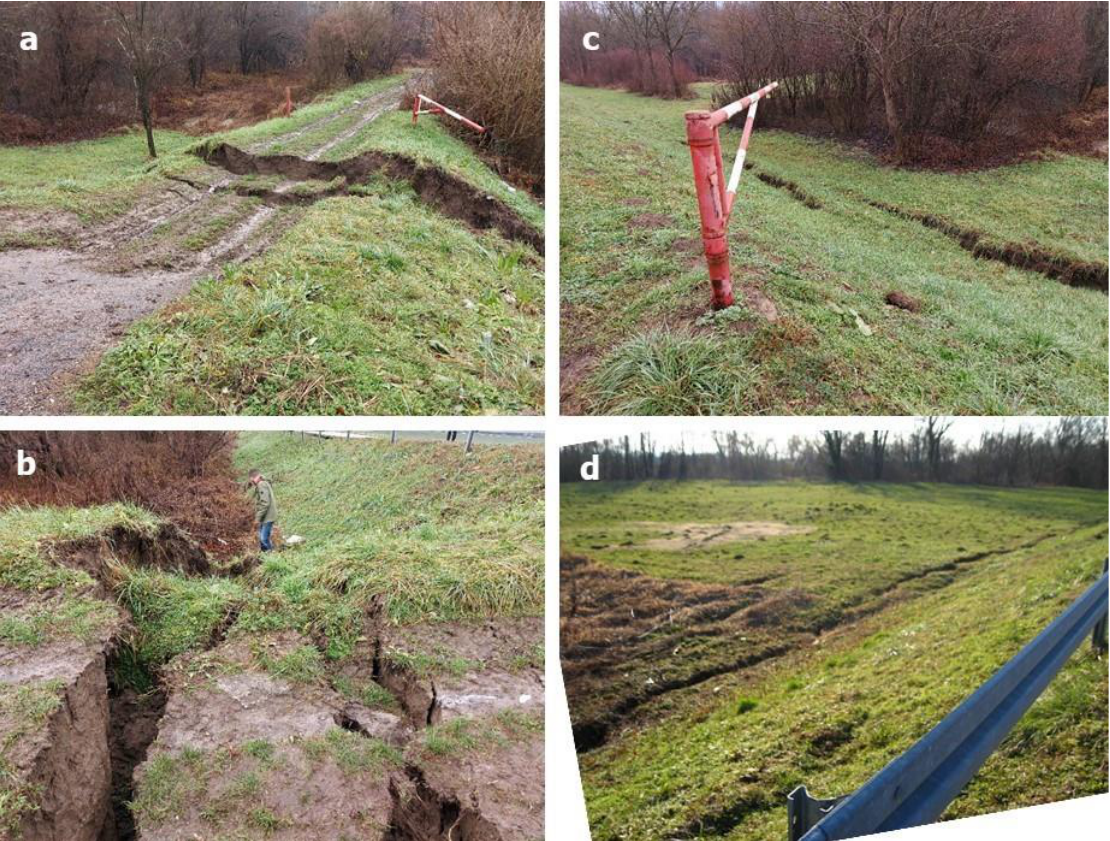
Figure 8. Embankment near Palanjek. A crack over 30 cm wide crosses the connection between two perpendicular embankments ( a – c ) [15]. The ejecta are visible on both sides of the main embankment, as well as the longitudinal cracks along it over 15 cm wide ( d